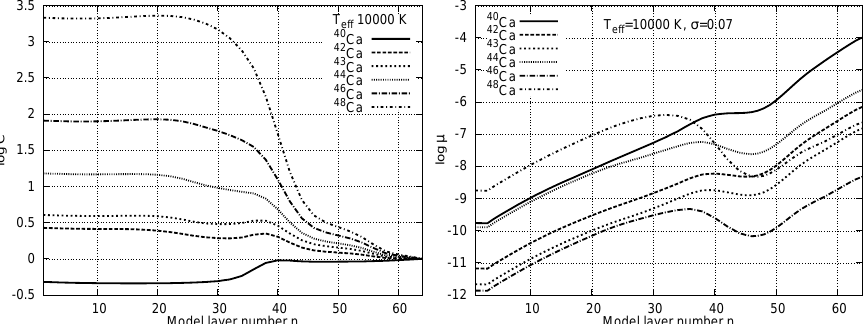
-0.5 Fig. 3. The same as in Fig. 1, but for T eff = 10 000 K. The mean value of the impact cross section is (cid:27) = 0 : 07 (cid:1) 10 (cid:0) 16 cm 2